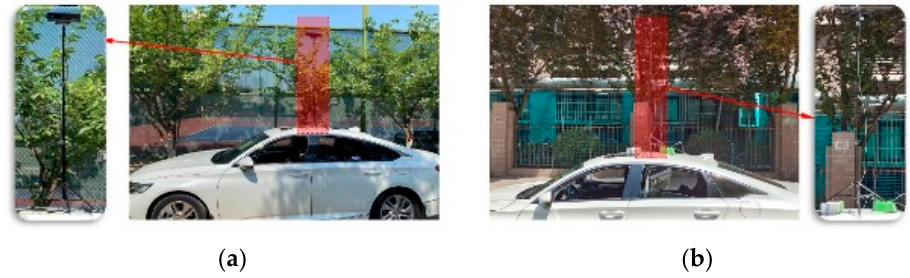
Figure 9. Schematic diagram of the data acquisition device. In ( a ), an infrared-based method was used to acquire the image depth. In ( b ), the image depth was acquired based on the binocular vision imaging method.